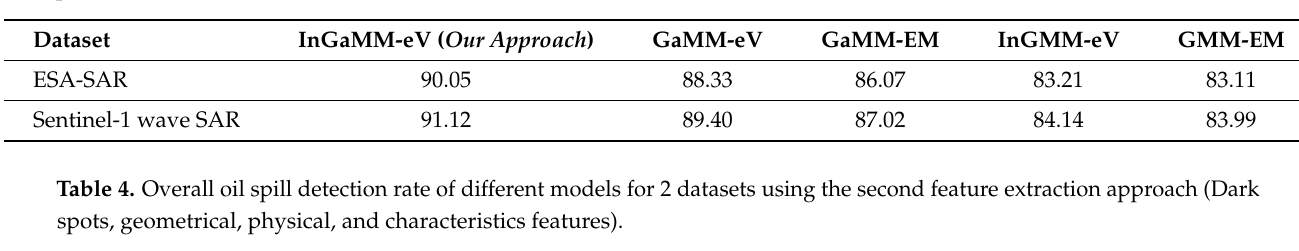
Table 3. Overall oil spill detection rate of different models for 2 datasets using the first feature extraction approach (ImageNet pretrained (resnet50) features) .